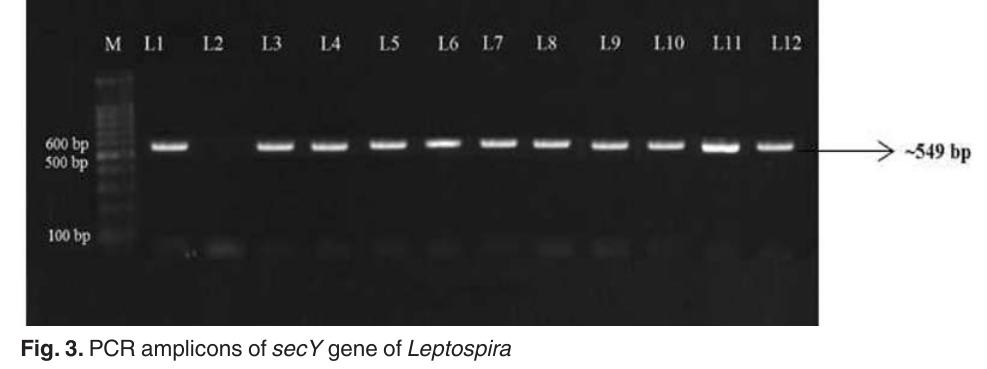
Fig. 3. PCR amplicons of secY gene of Leptospira